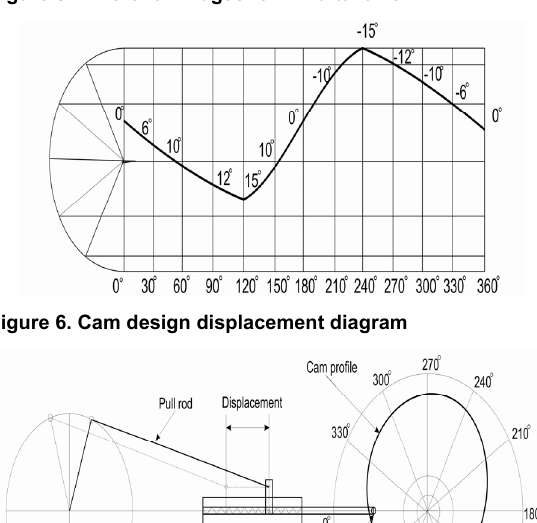
Figure 5. Different linkages for wind turbine